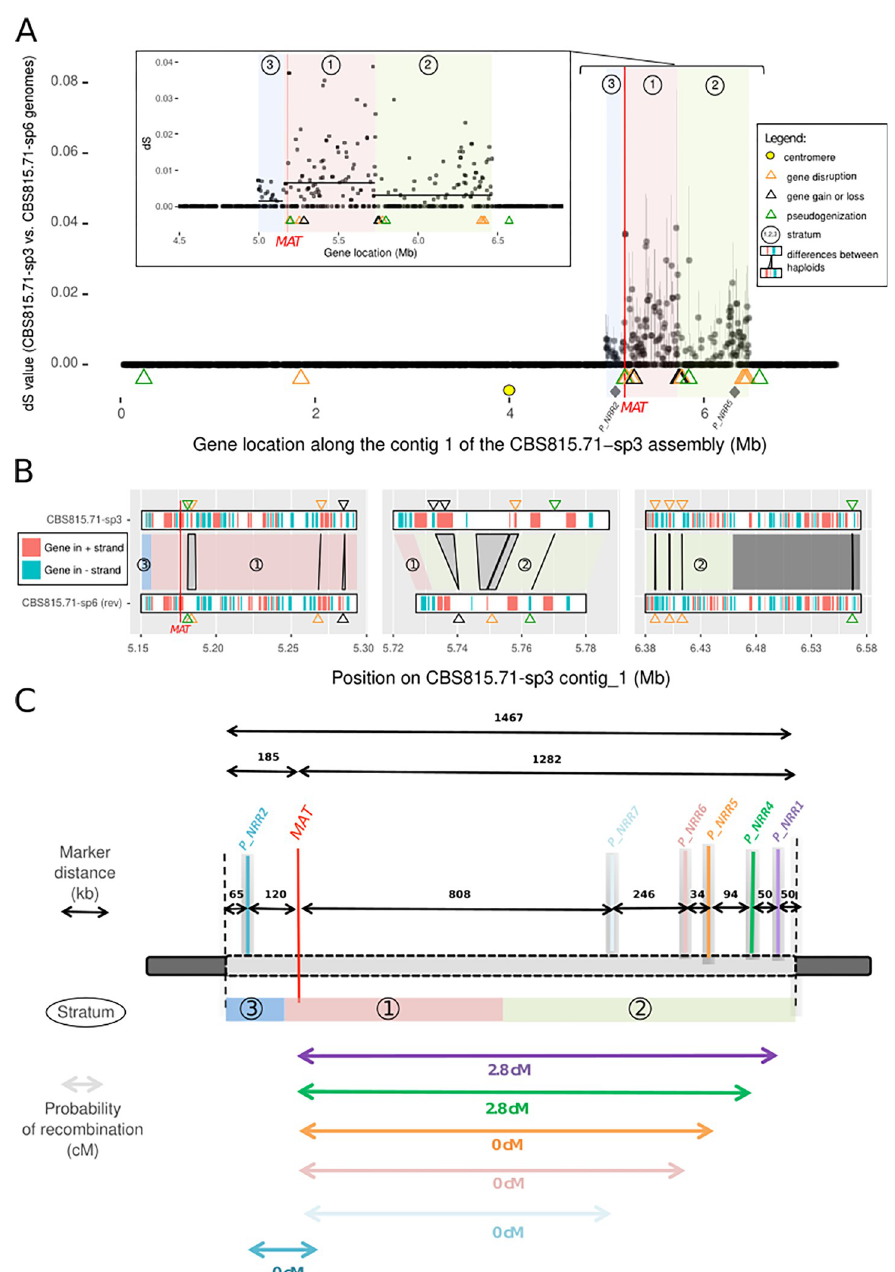
Fig 5. Evidence for recombination suppression around the mating-type locus in the Schizothecium tetrasporum CBS815.71 strain. A. Synonymous divergence (d S ) and its standard deviation along the mating-type chromosome in the S . tetrasporum CBS815.71 strain. d S was calculated per gene, between the orthologs common to the CBS815.71-sp3 and CBS815.71-sp6 assemblies and was plotted, according to the CBS815.71-sp3 assembly gene position (contig 1), along the x- axis. The mating-type locus is indicated with a red vertical line. The putative centromere is indicated with a yellow circle. The P_NRR2 and P_NRR5 markers, which displayed no recombination event with the mating-type locus, are indicated with gray diamonds. The inset shows a zoom on the three strata, with d S values in the region located between 4.5 Mb and 6.5 Mb of the contig 1; black horizontal bars represent the mean d S values of evolutionary strata 1, 2, and 3, respectively. In both plots, evolutionary strata 1, 2, and 3 are indicated by red, green and blue rectangles, respectively, and their numbers in circles. Gene disruption, gene gain or loss and pseudogenization events are indicated by orange, black and green triangles, respectively. B. Zoom in the regions with putative deleterious mutations identified as synteny breaks near strata edges. Links between CBS815.71-sp3 and CBS815.71-sp6 assemblies correspond to gene-disrupting, pseudogenizing or gain/loss events induced by indels, point mutations disrupting